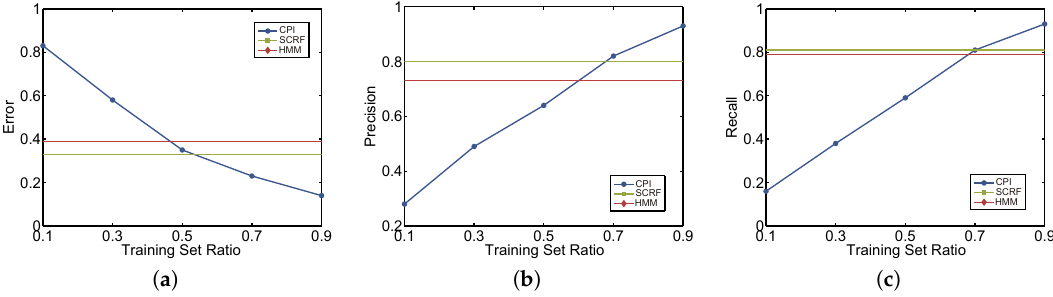
Figure 11. Experimental results by different training ratios. ( a ) Error; ( b ) Precision; ( c )